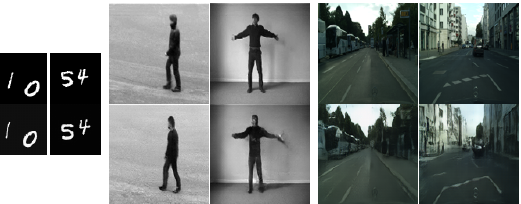
Figure 1. Example predictions for the MovingMNIST, KTH Action, and Cityscapes dataset. Top row: Last observed input frame. Bottom row: Next frames predicted by our